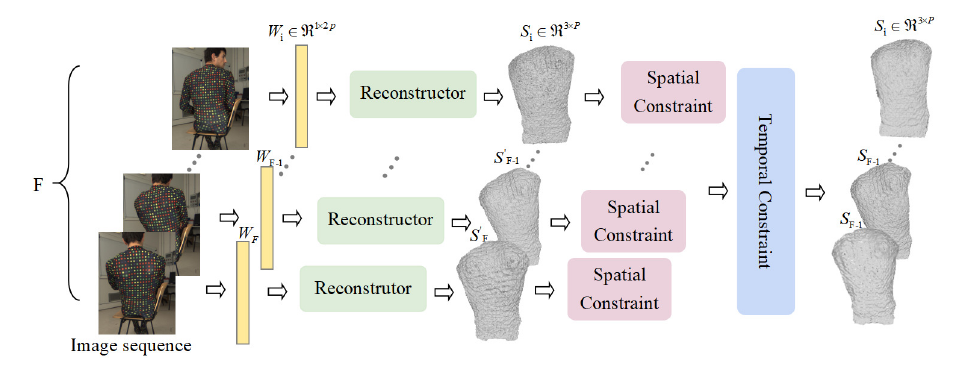
Figure 1. Overall framework of the deep spatial–temporal non-rigid structure from motion (DST- NRSfM)